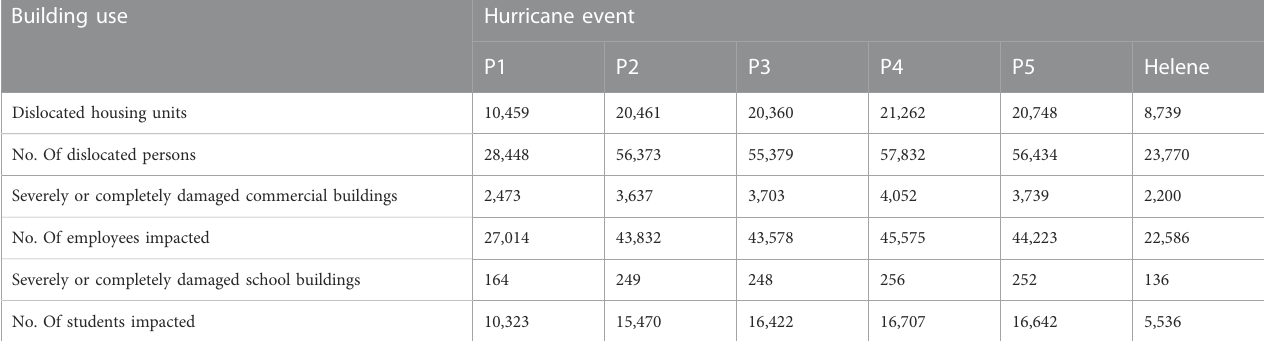
TABLE 3 Dislocated households, and employment and school disruption